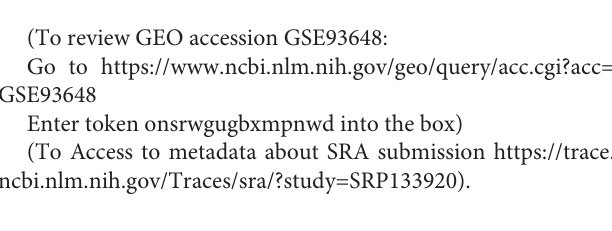
FIGURE S2 | Impact of the functional indels on the secondary structures of the transcript. (A,B) Global-free energy of the indel-containing region (positions 360–622, Solyc05g008070 ) and of the indel-lacking region (positions 360–638, Solyc07g049700 ), respectively. (C) Impact of the artificial insertion of the indel in the indel-lacking